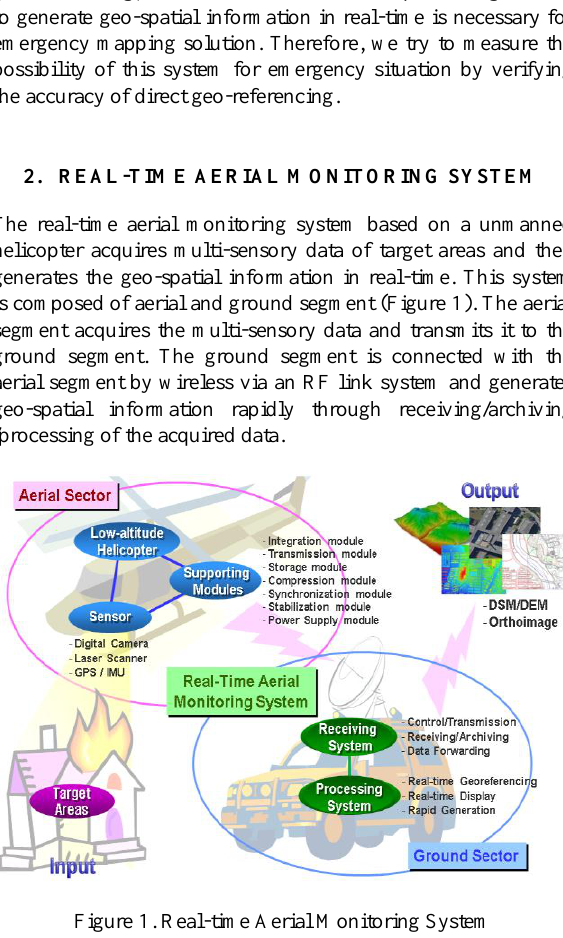
Figure 1. Real-time Aerial Monitoring System